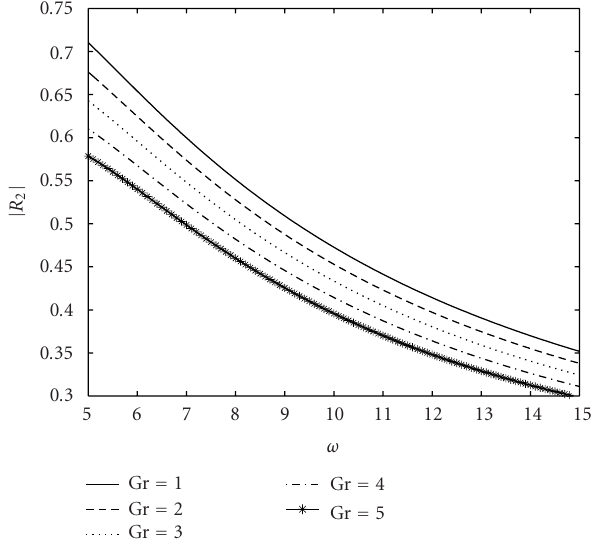
Figure 4.7. Amplitude of the shear stress due to main flow for S = 1 . 0.